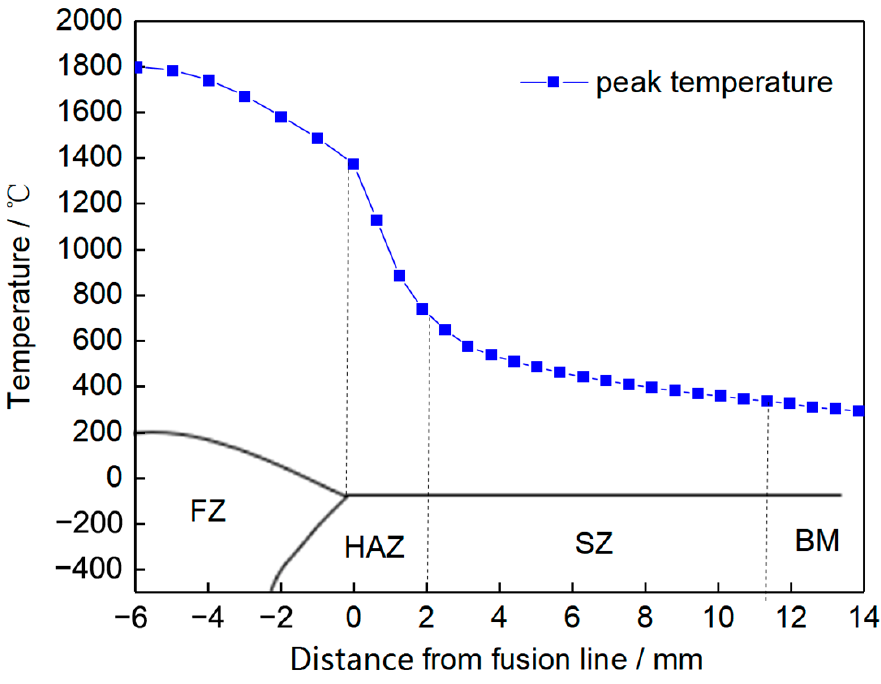
Figure 14. Peak temperature distribution along L2.